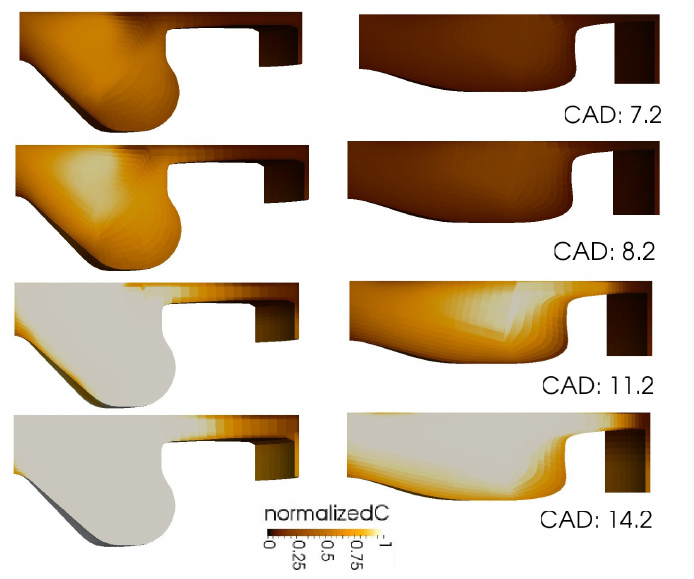
Figure 20. Comparison of the combustion evolution among baseline and optimized combustion.